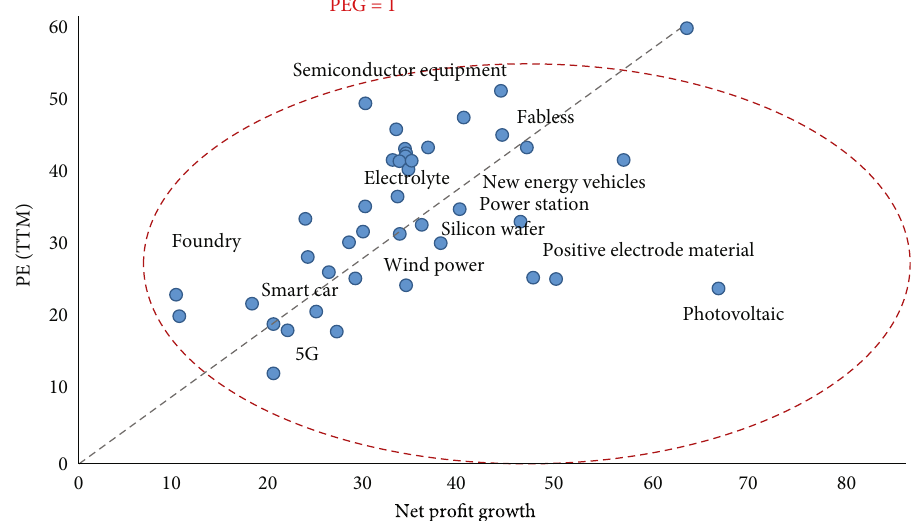
Figure 2: Risk and return in independent scenarios for di ff erent X values.